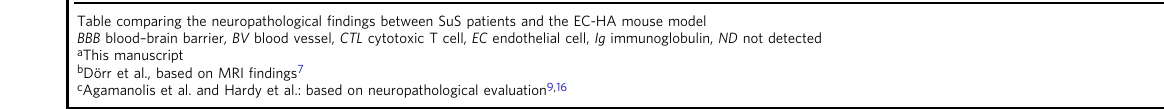
Table comparing the neuropathological fi ndings between SuS patients and the EC-HA mouse model BBB blood – brain barrier, BV blood vessel, CTL cytotoxic T cell, EC endothelial cell, Ig immunoglobulin, ND not detected a This manuscript b Dörr et al., based on MRI fi ndings 7 c Agamanolis et al. and Hardy et al.: based on neuropathological evaluation